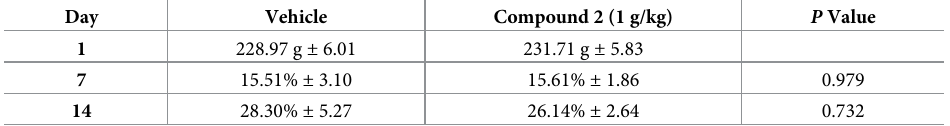
� Data are expressed as a mean ± S.E.M (n = 3) and analysed by independent samples t-test, p > 0.05 for compound 2-treated group compared with the vehicle